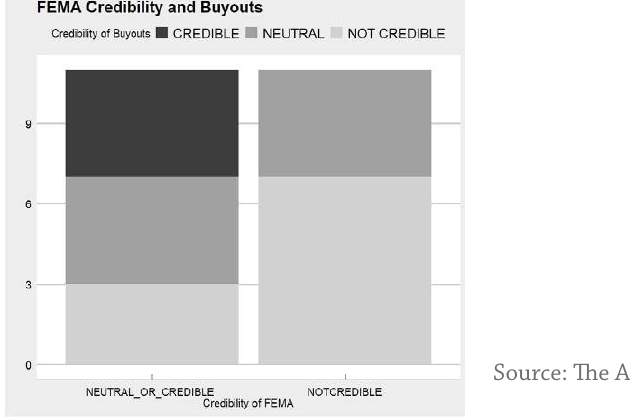
Source: The Authors